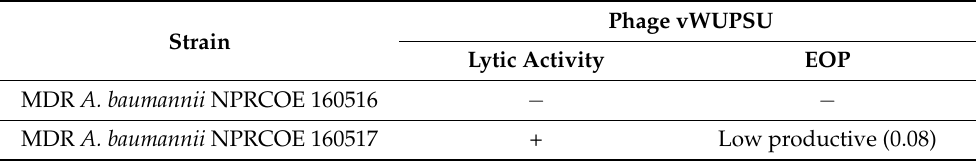
Table 1. Host range infection and EOP of phage vWUPSU.